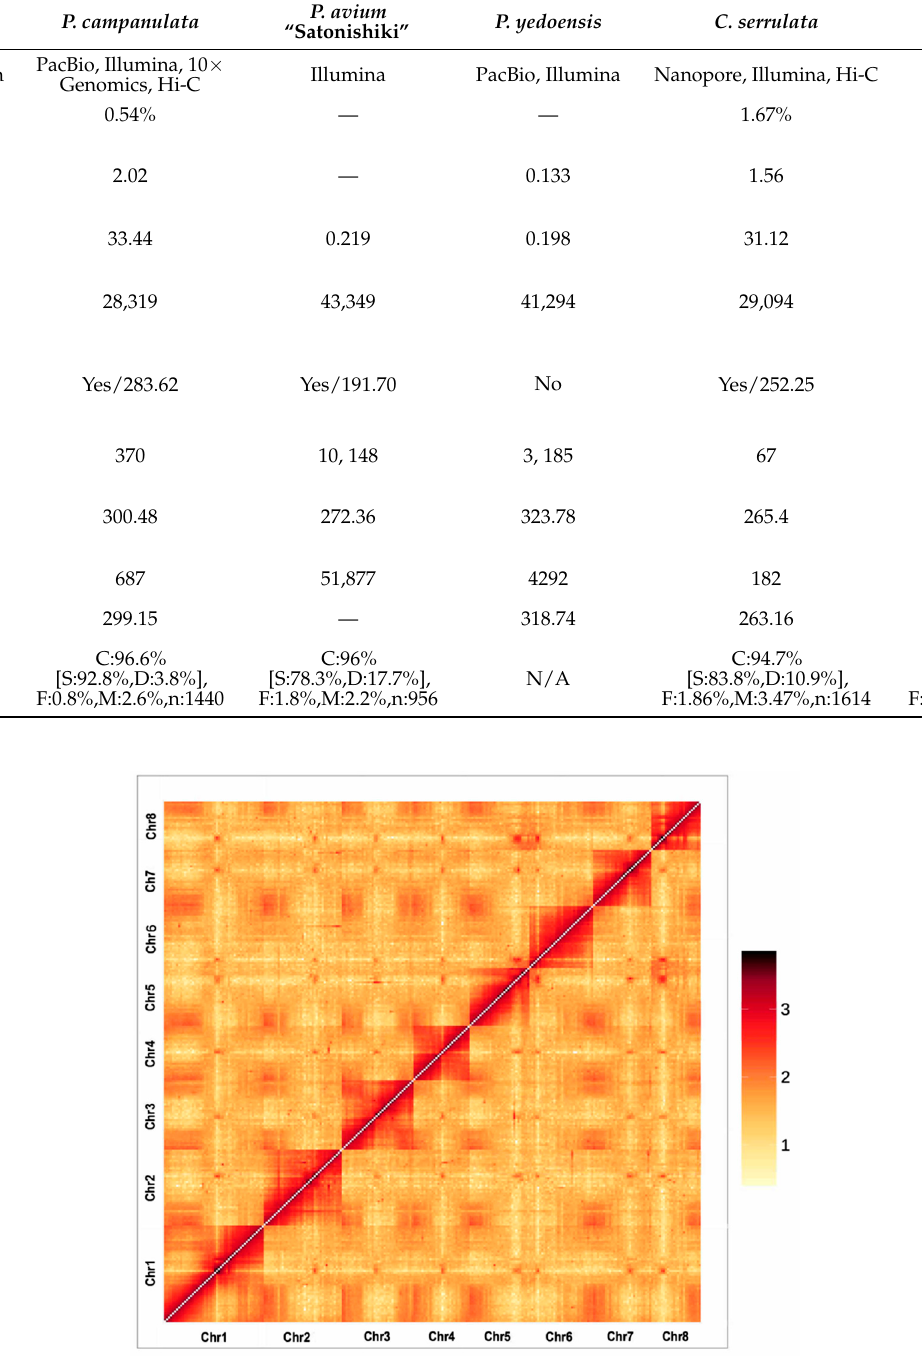
Figure 2. Hi-C contact map revealing extensive hierarchical chromatin interactions in the genome of P. campanulata . Table 1. Comparison of the genome assembly among the four cherry species.